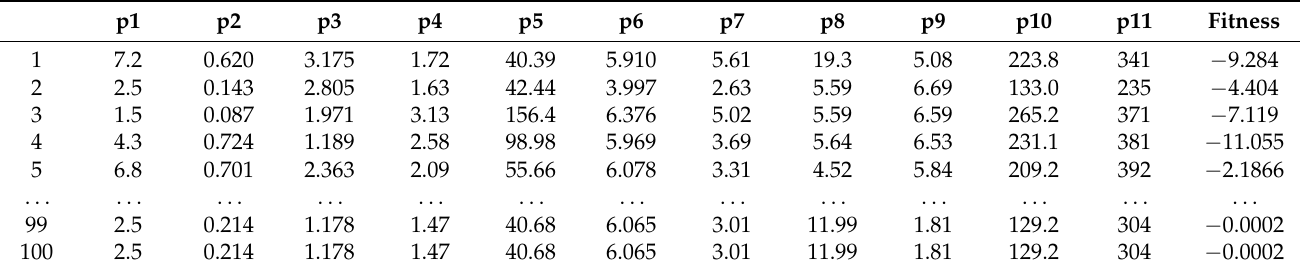
Table 7. GA iterative process.